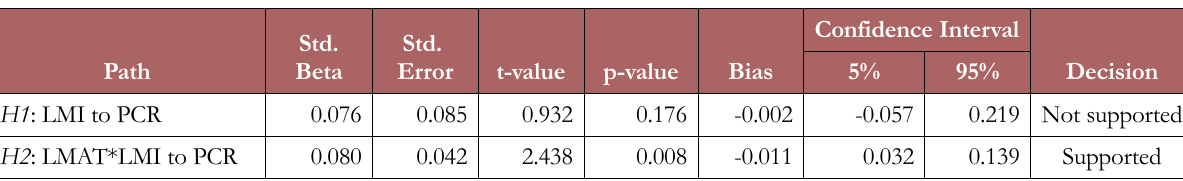
Table 7. Summary of Hypotheses